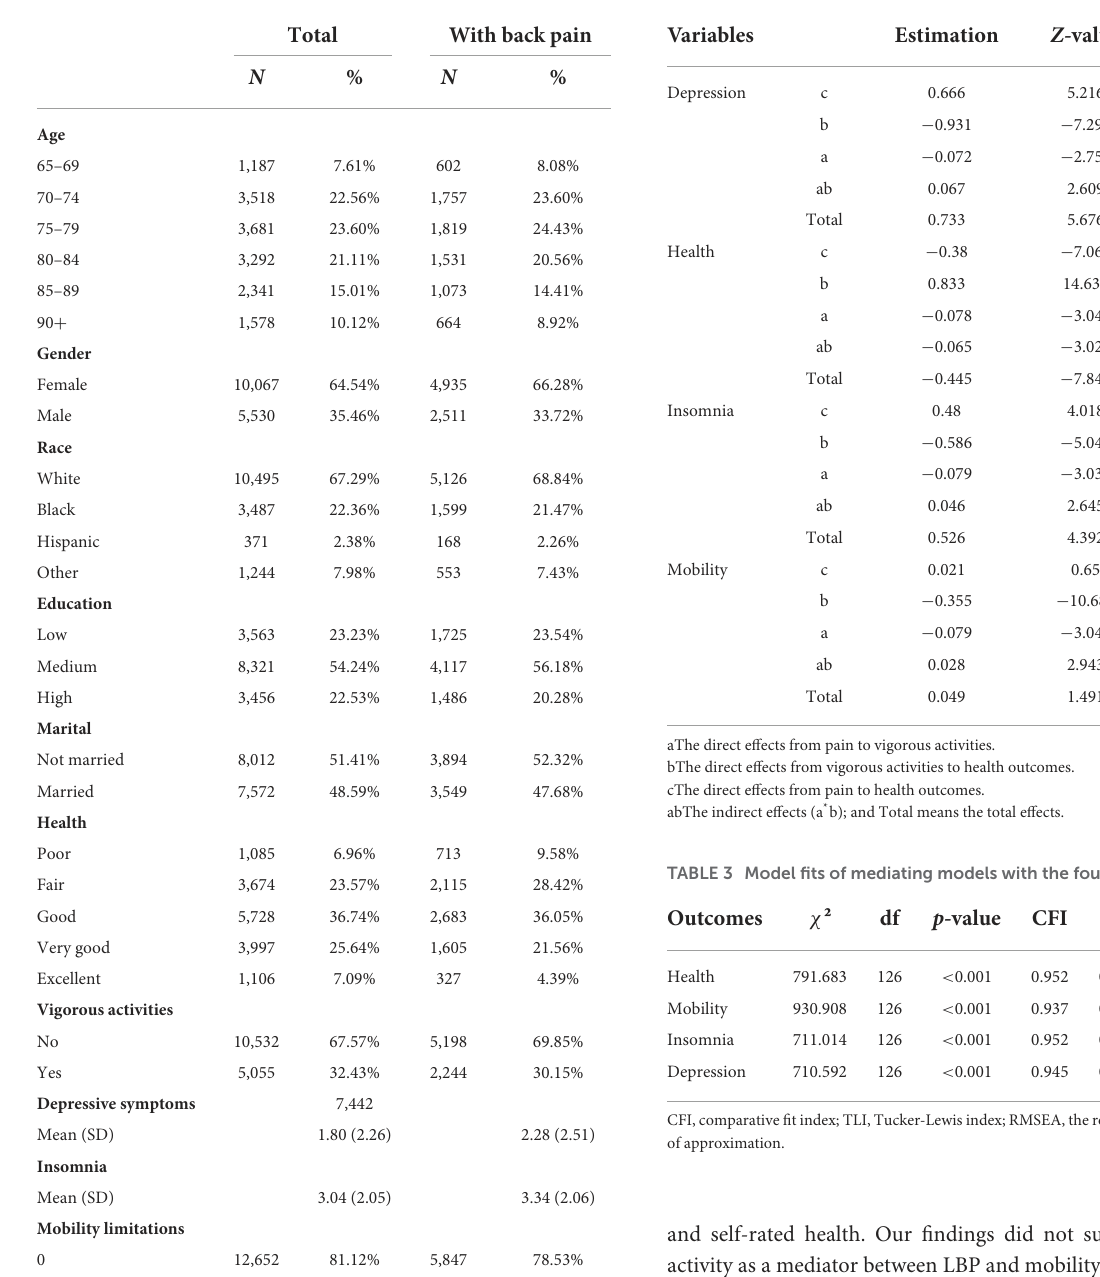
TABLE 1 Sample characteristics. TABLE 2 Summary of the mediating effects of models.